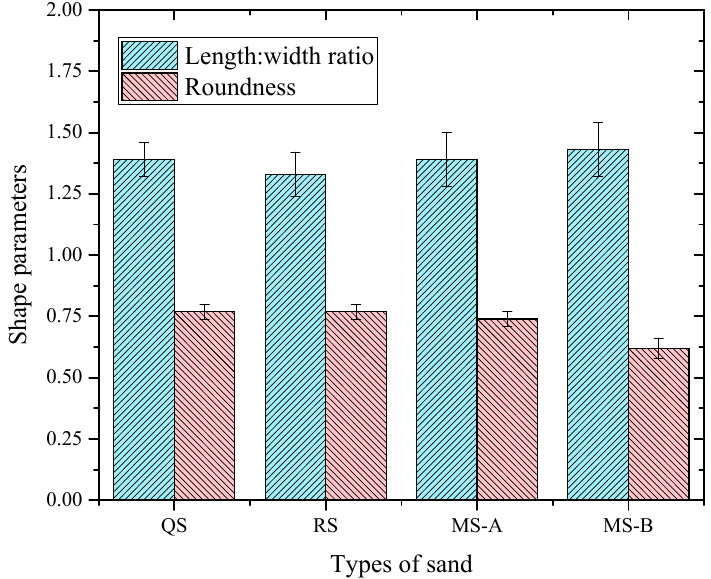
Figure 4. Image analysis of four kinds of sand particles.